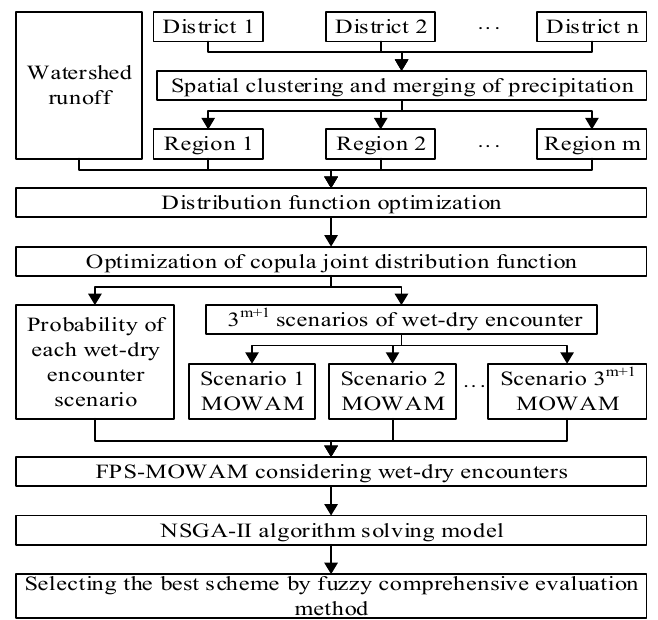
Figure 1. The flow diagram for the full probability scenarios considering wet–dry encounters be- tween basins and regions